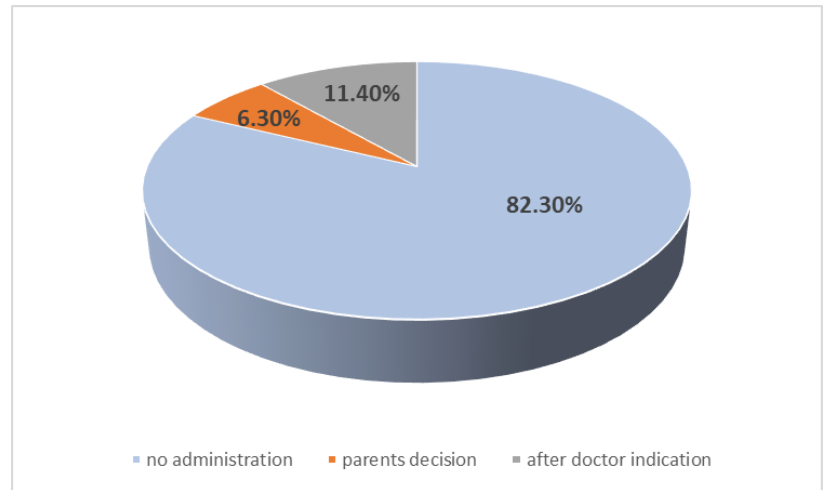
Figure 3. Administration of therapy after vaccines